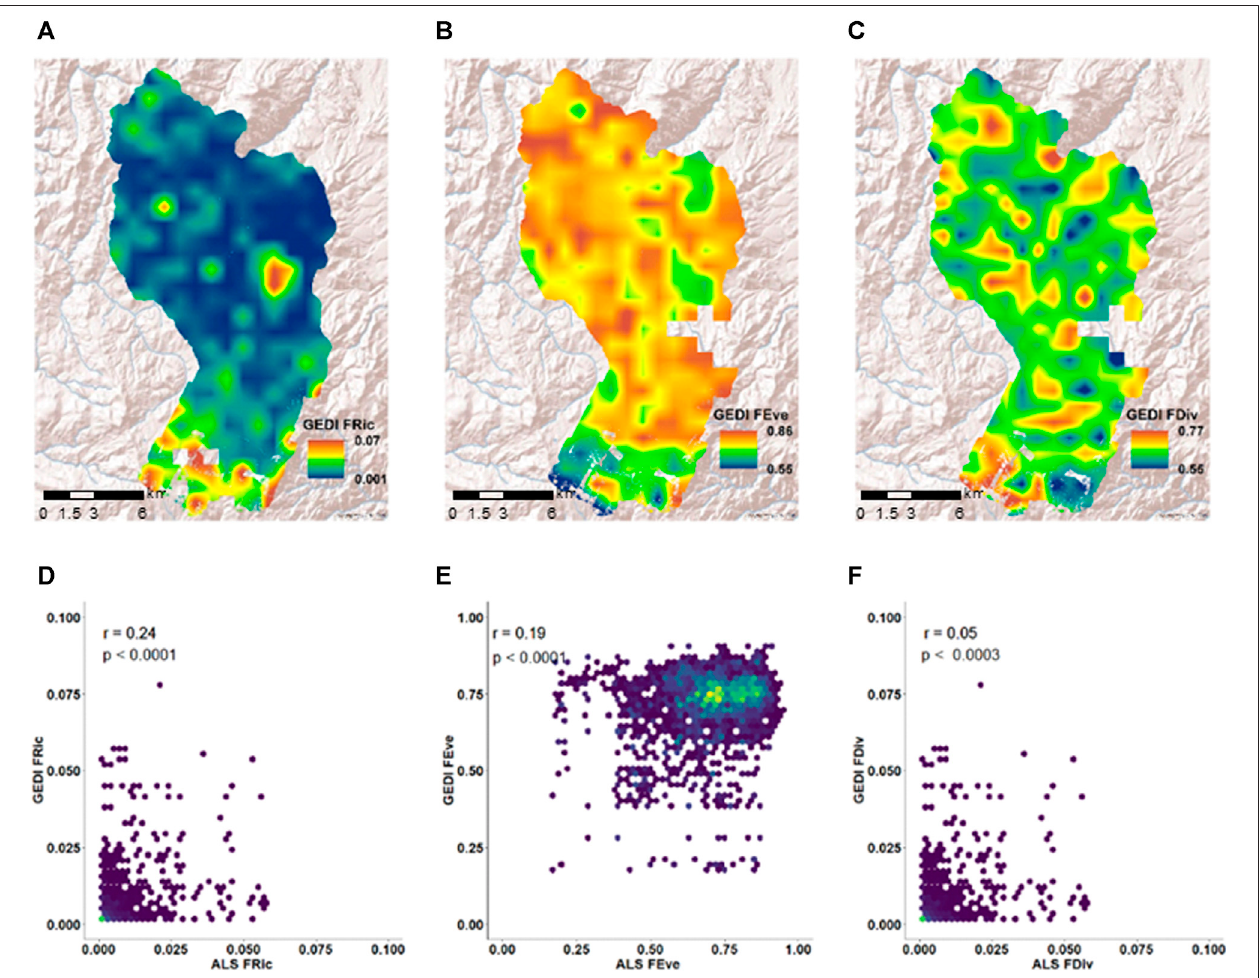
FIGURE 8 | Functional diversity mapped using a 1,000 m spatial neighborhood GEDI data and their correlation with ALS derived functional diversity indices. Top row: GEDI predicted (A) functional richness (GEDI FRic), (B) Functional evenness (GEDI FEve), (C) Functional divergence (GEDI FDiv). Bottom row: Correlation between (D) ALS functional richness (ALS FRic) and GEDI predicted functional richness (GEDI FRic), (E) ALS functional evenness (ALS FEve) and GEDI predicted functional evenness (GEDI FEve), (F) ALS functional divergence (ALS FDiv) and GEDI predicted functional divergence (GEDI FDiv).